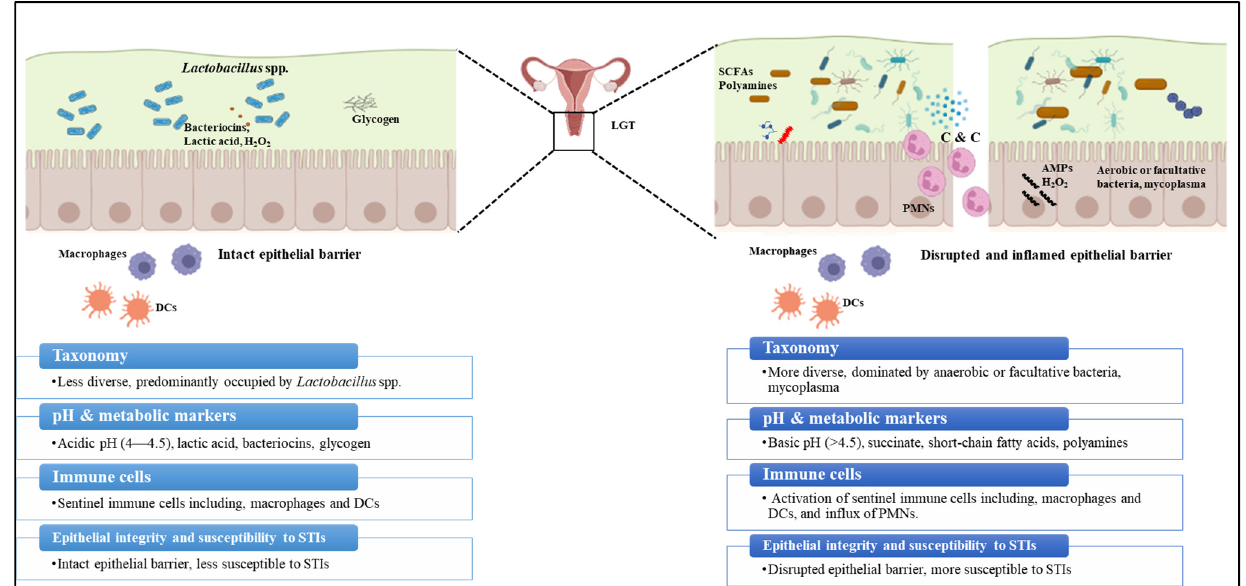
Figure 3. Impact of a healthy vs dysbiotic microbiome on vaginal ecology. Left Panels: A healthy vaginal microbiome is less diverse and is dominated by Lactobacillus spp. The metabolites of Lactobacillus spp. including lactic acid, H 2 O 2 , and bacteriocins that create an environment that is not conducive for the growth of anaerobic bacteria or pathogens. Right Panels: Disruption to the core healthy microbiome, as in the case of BV, leads to an environment where Lactobacillus spp. is replaced by anaerobic facultative bacteria. This is associated with an increase in pH, SCFAs, and polyamines. Additionally, there is an induction of innate immune responses resulting in upregulation of cytokine and chemokine production, the influx of PMNs, and disrupted epithelial barrier increasing the susceptibility to STIs. DCs : dendritic cells; SCFAs : short-chain fatty acids; C & C : chemokines and cytokines; AMPs : antimicrobial peptides; LGT : lower genital tract; and PMNs : polymorphonuclear leukocytes. This figure was created with Biorender.com.